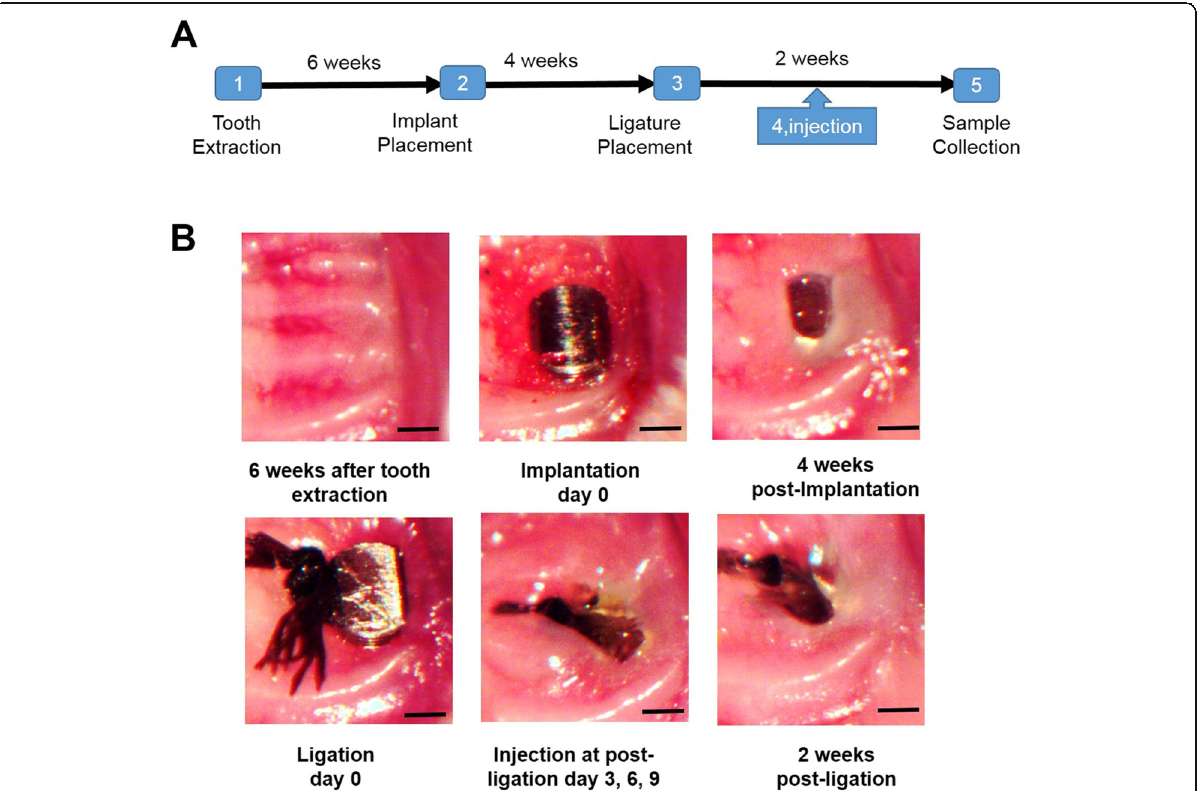
Fig. 1 Mouse model of ligature-induced experimental peri-implantitis. ( a ) Tooth extraction: left maxillary first and second molars extracted at 4weeks old and the tooth extraction socket healed well with smooth gingiva surface after 6weeks post-extraction. Implant placement: implant was put in alveolar bone without flap elevation. Ligature placement: at 4weeks post-implant, 7-0 ligatures were applied under the fixture head. Gingival injection: injections for animals were administered three times on days 3, 6, and 9 during 14days ligation period. Sample collection: 14days post-ligation, the gingival tissues and the skulls were collected. ( b ) Images depicting processing steps of the experimental design (scale bar, 500 μ